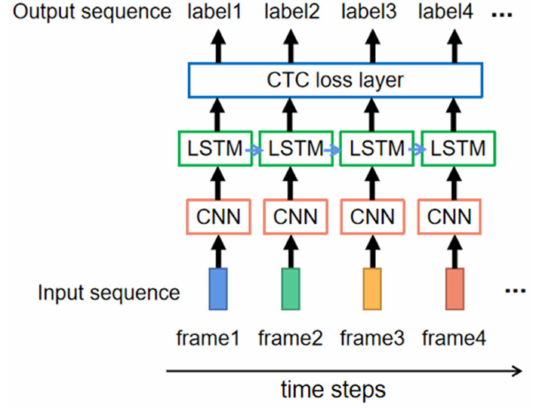
Figure 7. CTC-based sequence recognition